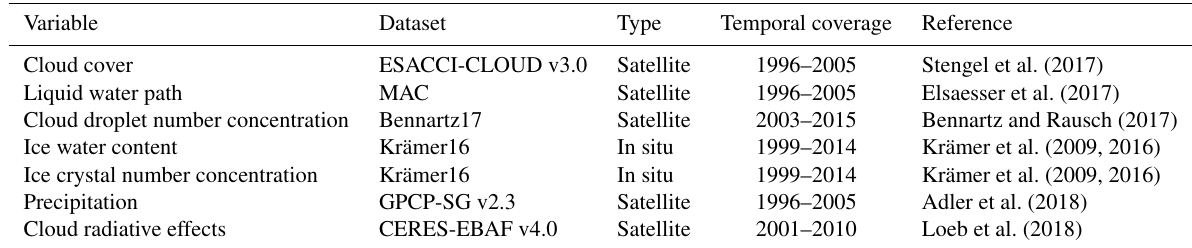
Table 2. Summary of the observational dataset used for tuning cloud and radiation variables in